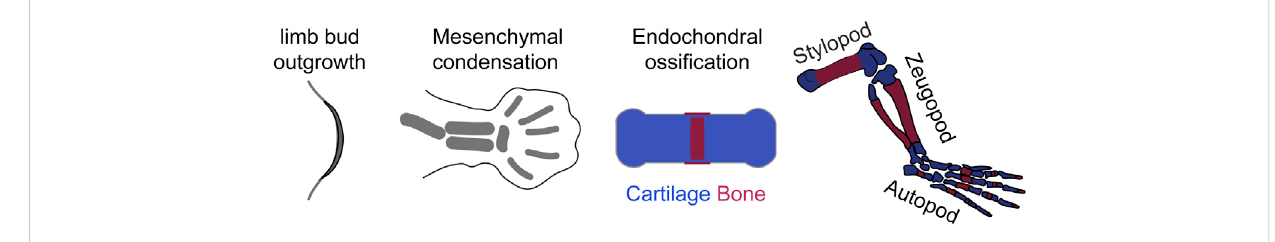
FIGURE 3 Steps in tetrapod limb development where mTOR may play a